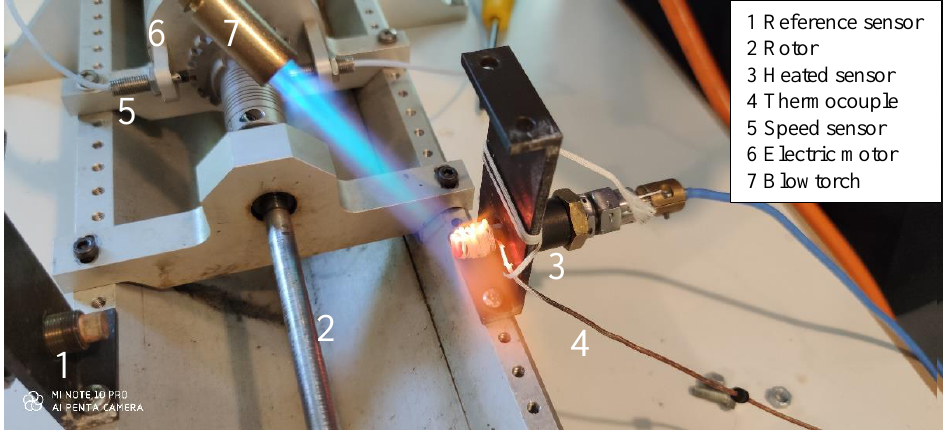
Figure 7. Inductive probe fired at the rotor rig. A series of measurements were made with gradually increased temperature (Figure 8). The signals from the sensors were fed into the multi-stage adjustable amplifier of the conditioning system. The amplified signals were sampled with frequency of 500 kHz. For each temperature point, 20 s of data was recorded in the pcm format and processed in MATLAB.